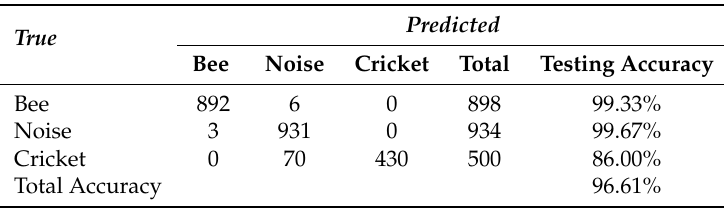
Table 18. Confusion matrix for random forests on BUZZ2 testing dataset.